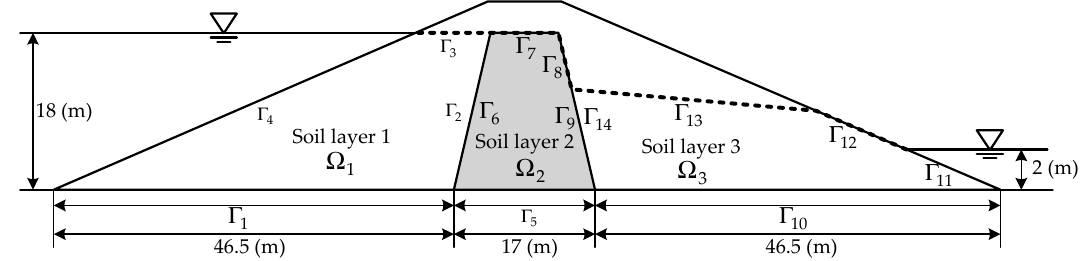
Figure 12. The cross section and soil layer configuration of the zoned–earth dam for the analysis.